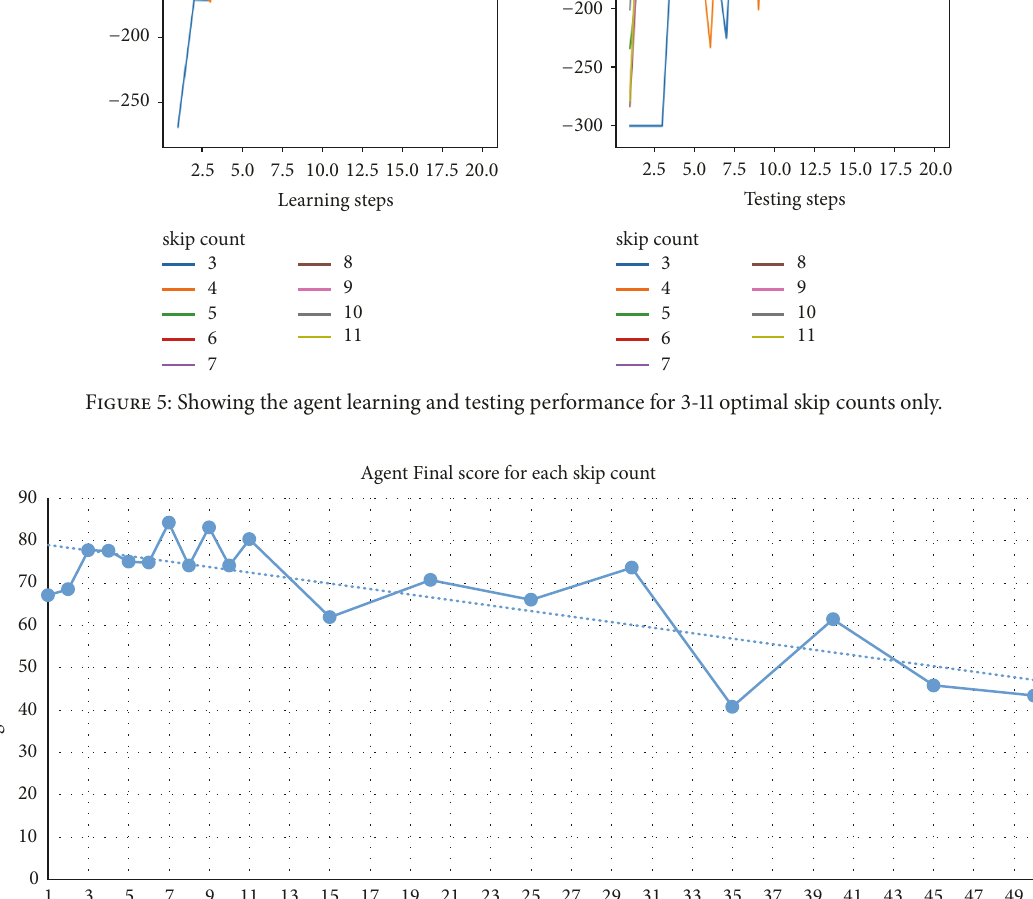
compute the final score, but in fact it is used while training the agent to help understand its goal. In such type of scenario(s), the agent movement matters where it is not allowed to move forward or backward except left and